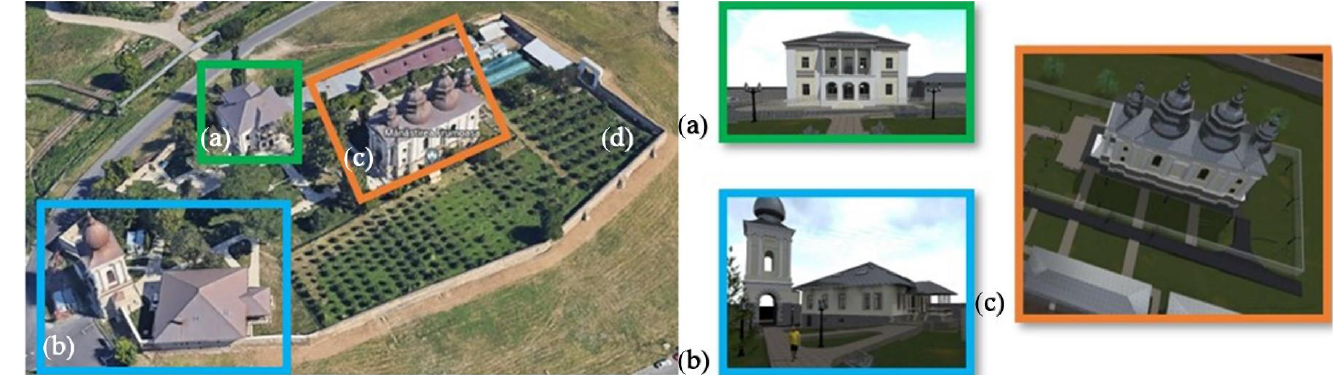
Figure 1. The Frumoasa monastery complex. ( a ) The Ruins of The Palace for Women; ( b ) The Bell Tower; ( c ) The Church of The Holy Archangels Michael and Gabriel and The Palace on The Walls; ( d ) The Enclosure Wall. Adapted from Google Earth [13]. ( d ) The Enclosure Wall. Adapted from Google Earth